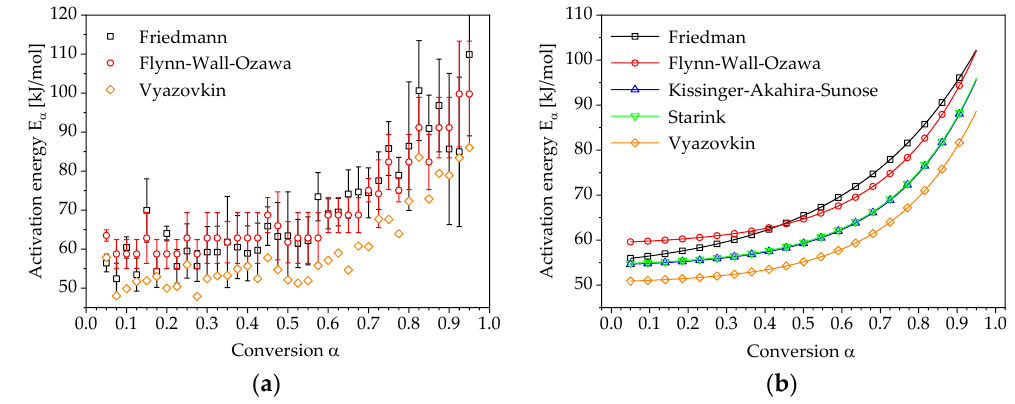
Figure 7. Dependence of activation energy in relation to reaction conversion: ( a ) experimental data; ( b ) data fitted to Equation (21).